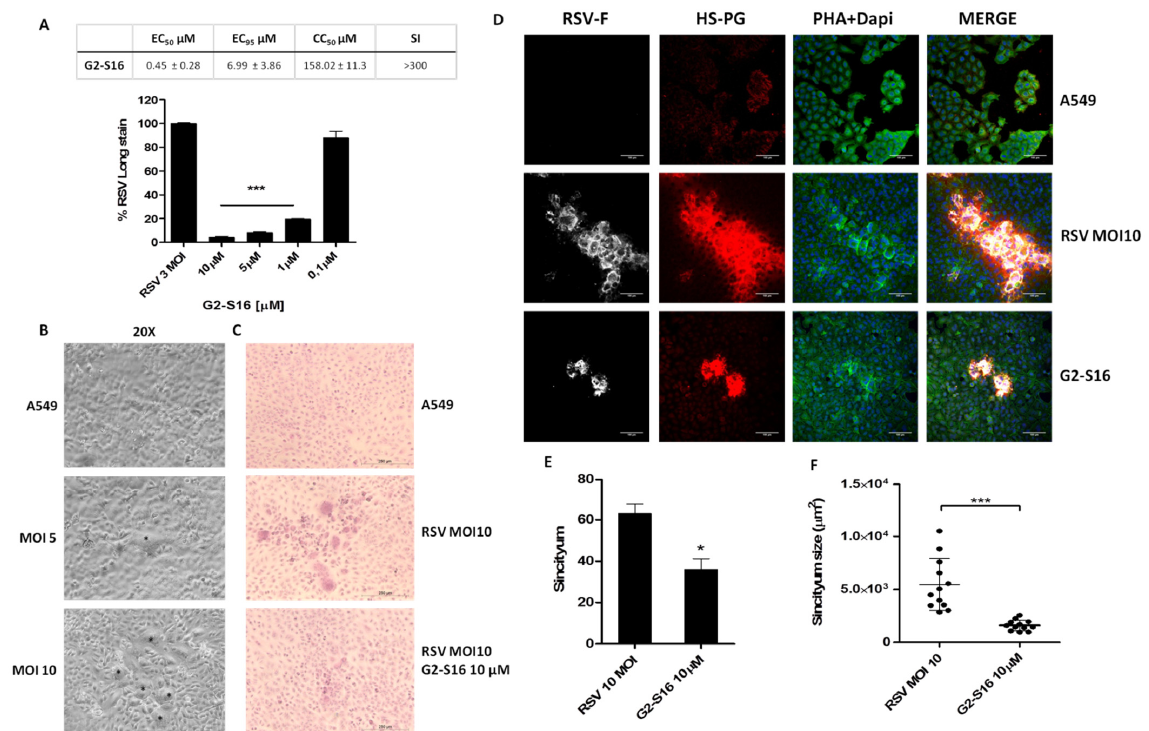
Figure 3. Syncytium formation assay. ( A ) A549 cells were infected at a MOI 3 to evaluate the inhibition of G2-S16 dendrimer. EC50, EC95, CC50, and SI were calculated. ( B ) A549 cells were infected at a different MOI of RSV to evaluate the syncytium formation (black asterisk). A549 cells were infected at a MOI 10 ( C – F ) of RSV and treated with G2-S16 dendrimer in a range of non-toxic concentrations. Then, 72 h post-infection, cells were ( C ) H/E stained or immune-stained for ( D ) RSV-F viral glycoprotein (white), HSPG (red), and actin filaments (phalloidin; green). Nuclei were stained with DAPI (blue). ( E ) Media of syncytium formation/well after 72 h post-infection. ( F ) Media of syncytium size in four random fields/experiment after 72 h post-infection analyzed with ImageJ software. Images are representative of three independent experiments. Data showed the media ± SD of three independent experiments. *: p < 0.05; ***: p < 0.001. As expected, in fields without the presence of RSV, the G2-S16 dendrimer is located inside A549 cells, mainly at the cellular surface (Figure 4; white arrows). These data are in concordance with cellular protection assay results, where the G2-S16 dendrimer is able to interact with A549 cells and protect RSV infection. In these fields where syncytium was generated, the G2-S16-FITC dendrimer was visualized inside the syncytium (Figure 4), suggesting that it could interfere with adjacent cells, avoiding syncytium spread.